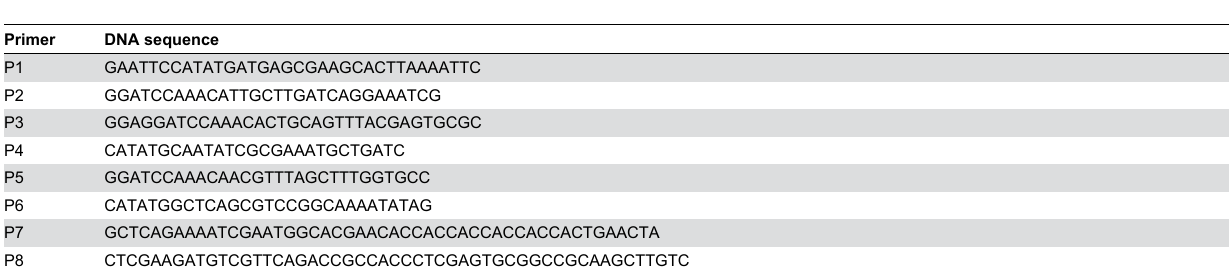
Table 1. Sequences of